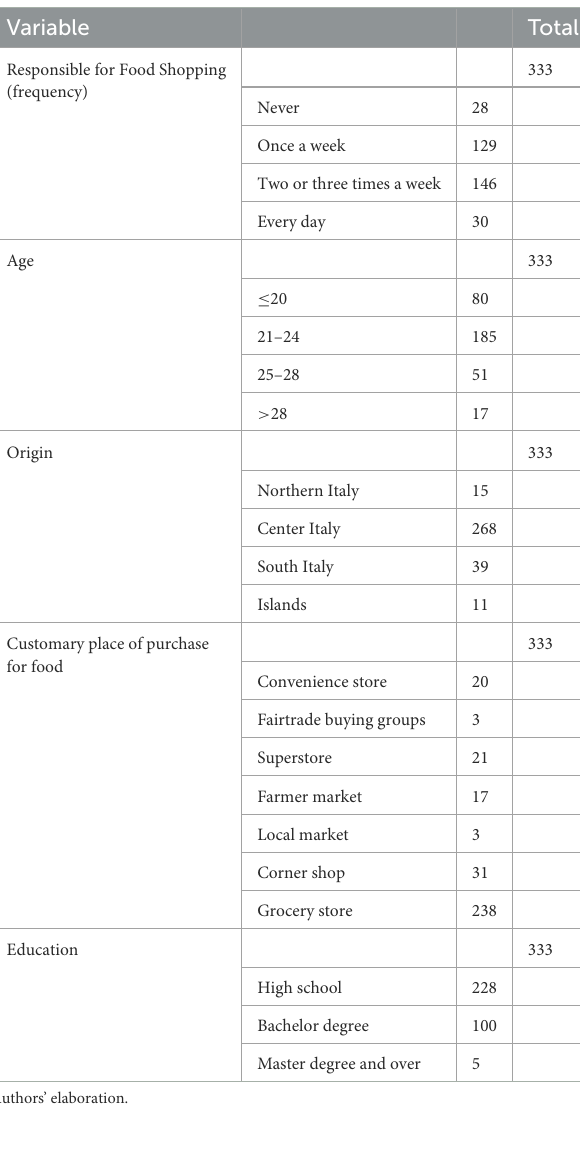
TABLE 3 Socio-demographic characteristics of the